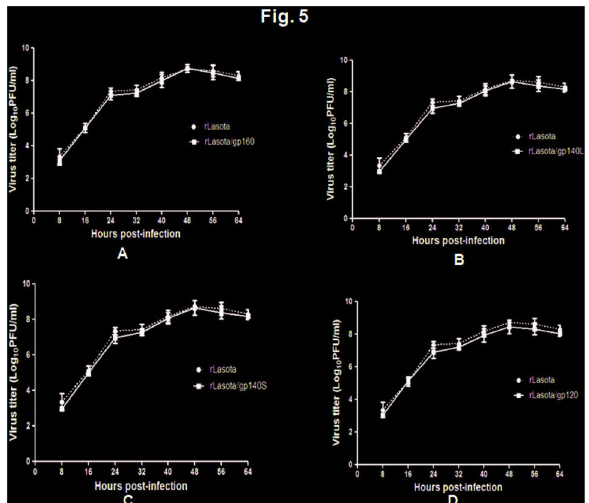
Figure 5. Comparison of multicycle growth kinetics of rLaSota/gp160 (panel A), rLaSota/gp140L (panel B), rLaSota/gp140S (panel C), rLaSota/gp120 (panel D) viruses, each compared with the empty vector rLaSota virus. DF1 cells were infected with each virus at an MOI of 0.01 and cell culture media supernatant aliquots were harvested at 8 h intervals until 64 h post-infection. The virus titers in the aliquots were determined by plaque assay in DF1 cells. Values are averages from three independent experiments. doi: 10.1371/journal.pone.0078521.g005 group showed significantly higher titer compared to all the other groups ( P <0.0001 for gp140S versus gp160 and gp40L groups, P =0.0008 for gp140S versus gp120 group) and on day 56, it showed significantly higher titer compared to rLaSota/gp160 and rLaSota/gp140L groups ( P <0.05). BaL.1 gp120 were measured by isotype-specific ELISA (Figure 7C and D). Responses were detected on day 21 after the first immunization in all of the groups, and responses peaked by day 42. The IgG1 response was strongest in rLaSota/gp140S group followed by rLaSota/gp120, rLaSota/gp140L and rLaSota/gp160 groups. On day 42, rLaSota/gp140S group showed significantly higher titer compared to all the other groups ( P <0.05), whereas on days 28, 56, 70 and 90, the IgG1 titer induced by rLaSota/gp140S was significantly higher compared to rLaSota/gp160 and rLaSota/gp140L ( P <0.05). The IgG2 response also was strongest in rLaSota/gp140S group followed by rLaSota/gp120, rLaSota/gp160, and rLaSota/ gp140L. On days 28 and 42, the IgG2 response induced by rLaSota/gp140S was significantly higher compared to rLaSota/ gp160 and rLaSota/gp140L ( P <0.05). We also calculated the ratio of serum IgG1:IgG2a to assess the Th1/Th2 balance. The ratio for rLaSota/gp160 was 1:3 on day 28 and 1:8 on day 90, indicative of a Th1-biased response. In contrast, the ratios for rLaSota/gp140L, rLaSota/gp140S, and rLaSota/gp120 varied from 1:0.7 to 1:1.4 on days 28 to 90 post-immunization and